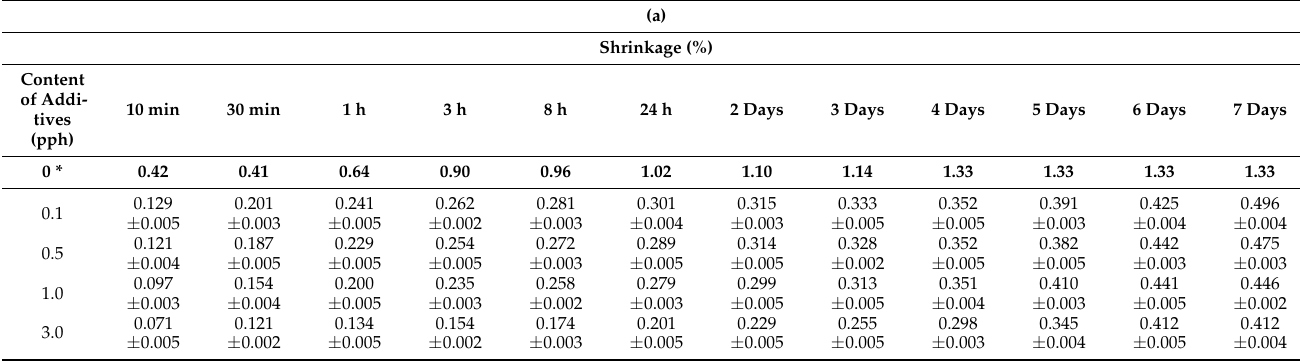
Table 4. Shrinkage of pressure-sensitive adhesives: marked with 0—adhesive without